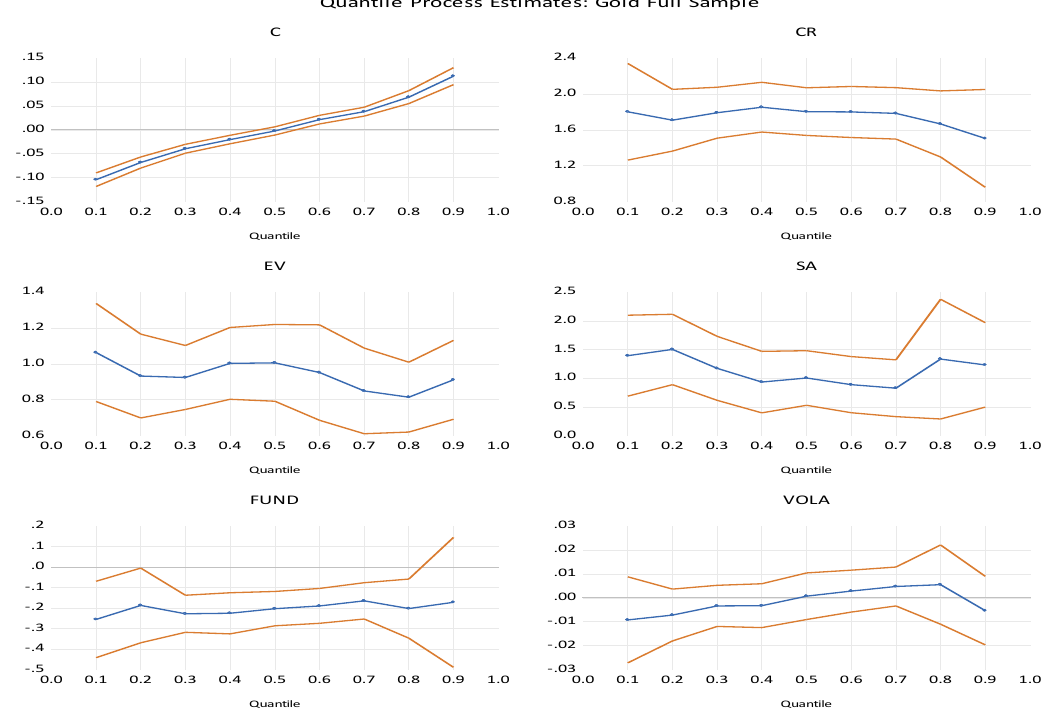
Figure 1. Quantile-Coefficients for Gold in Full-Sample.